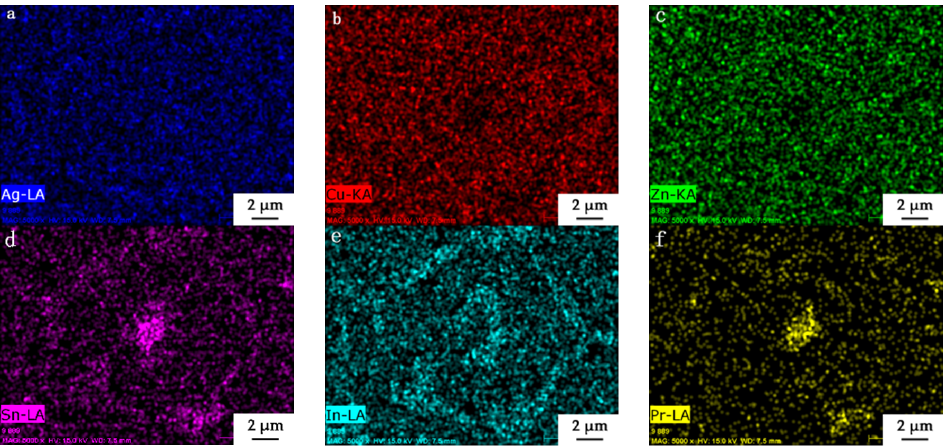
Figure 6. The elements mapping of SEM image of 12AgCuZnSn-5In-0.5Pr brazing filler metal in Figure 5h: ( a ) Ag, ( b ) Cu, ( c ) Zn, ( d ) Sn, ( e ) In, ( f ) Pr.